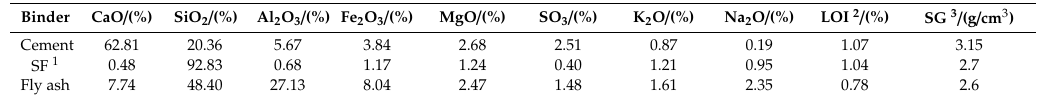
Table 5. Chemical composition of